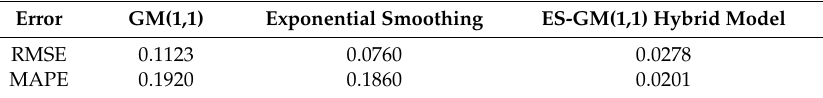
Figure 3. Comparison of the test results of single and combined models. Table 9. The RMSE and MAPE values for the three models.